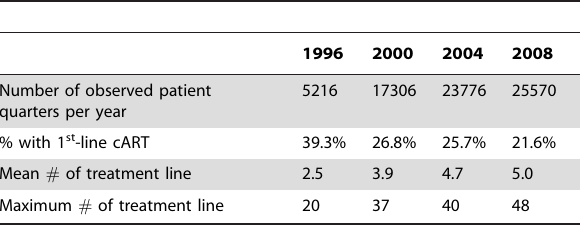
Table 4. Regimen lines over time (observed patient quarters in selected years).